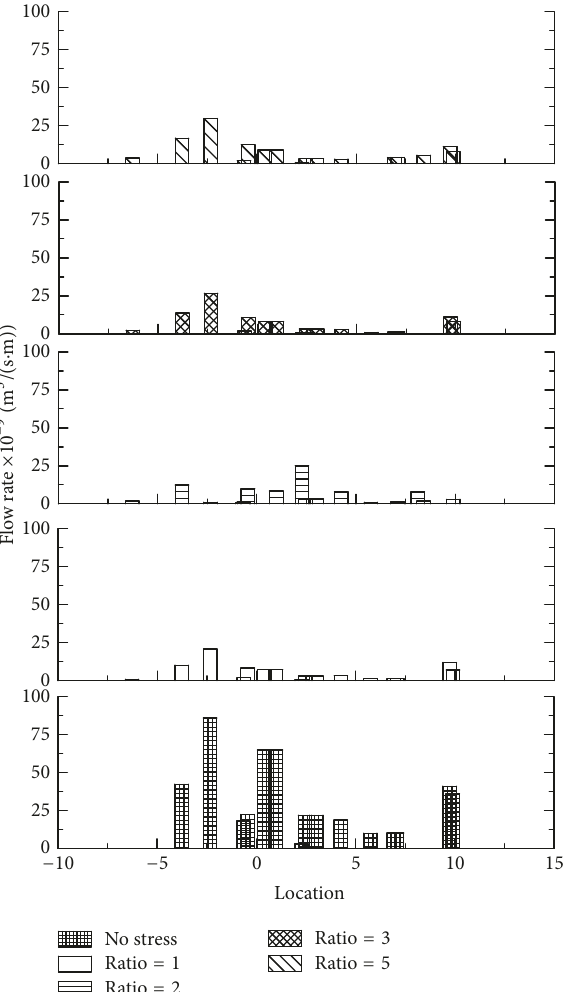
Figure 13: Flow rate distribution of fractures on the left outlet boundary.